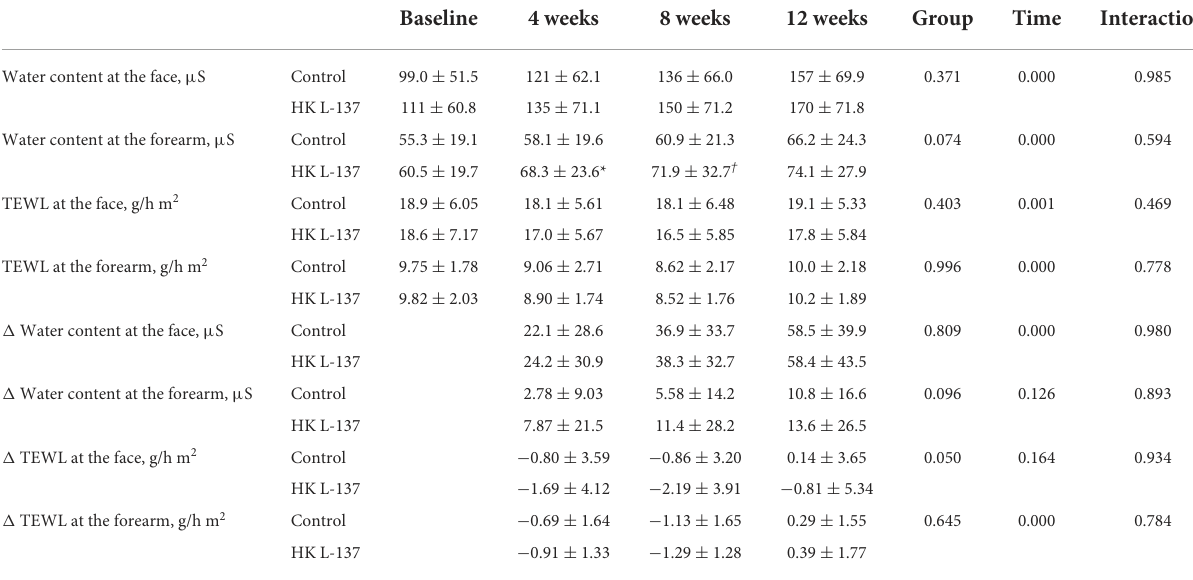
Two-way ANOVA a